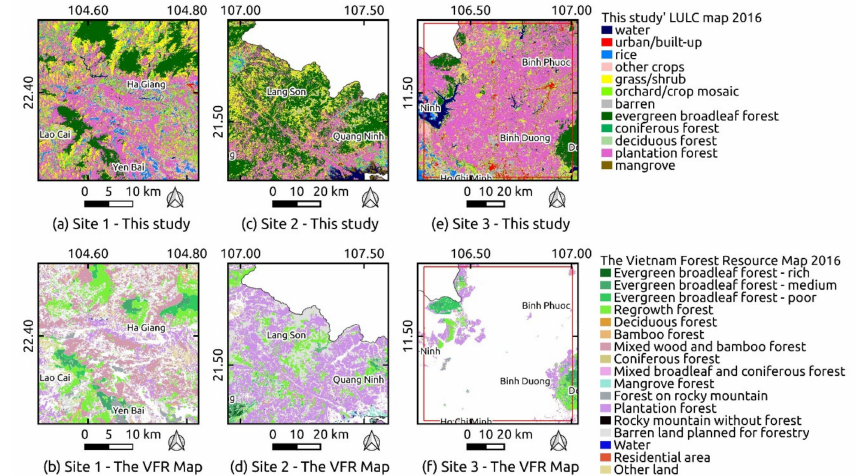
Figure 9. The three zoom-in sites in the VFR Map and in this study’s map. ( a ) Site 1 of this study’s map; ( b ) Site 1 of the VFR map; ( c ) Site 2 of this study’s map; ( d ) Site 2 of the VFR map; ( e ) Site 3 of this study’s map; ( f ) Site 3 of the VFR